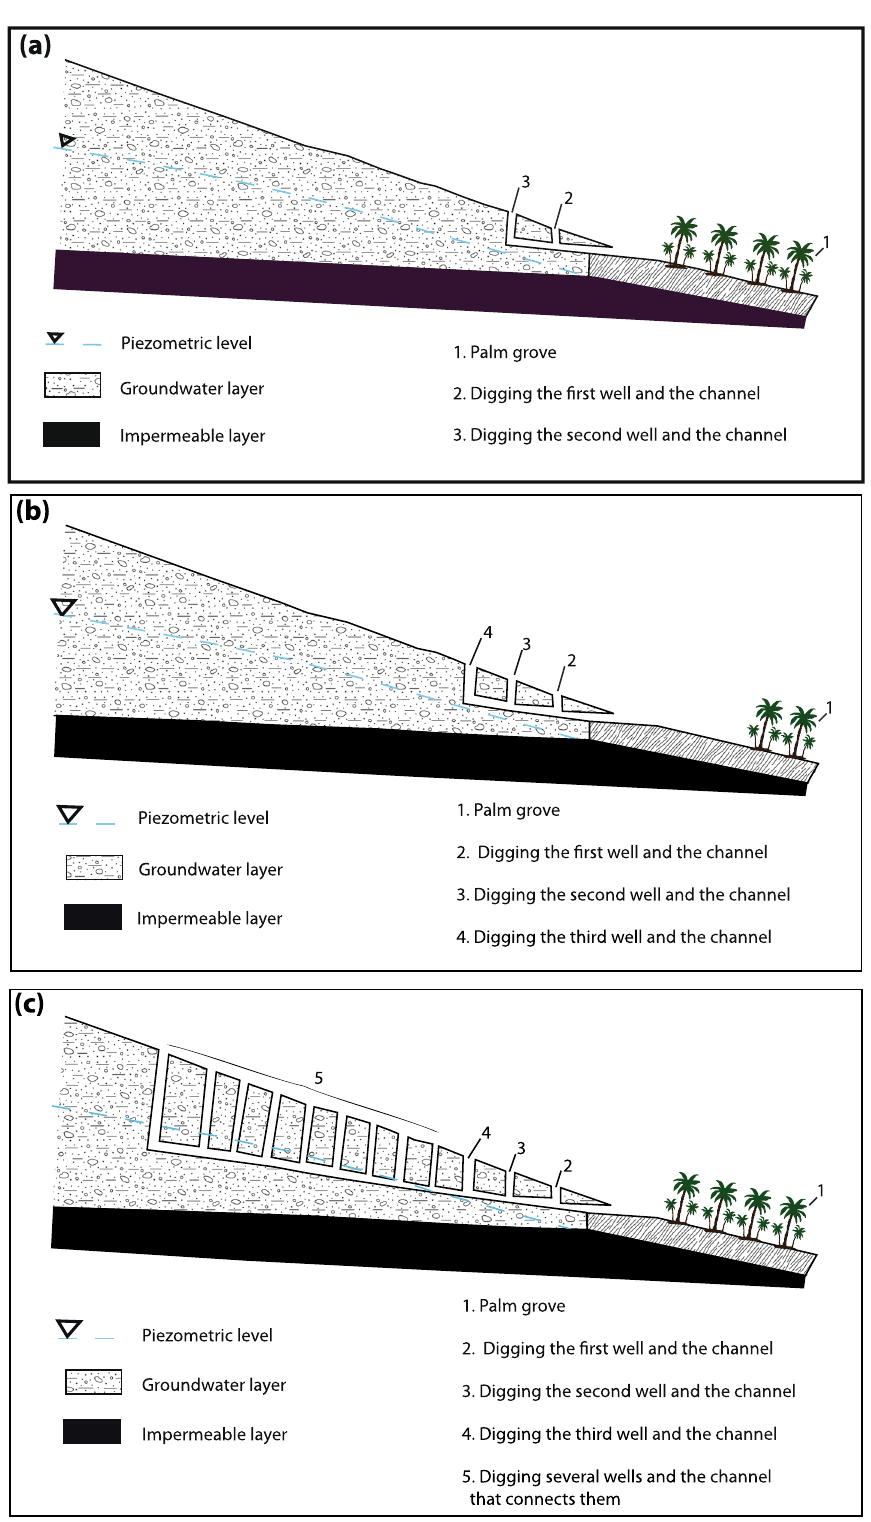
Fig. 4 The stages in the genesis of a khettara. a , stage 1; b , stage 2; c , stage 3 (Source: the